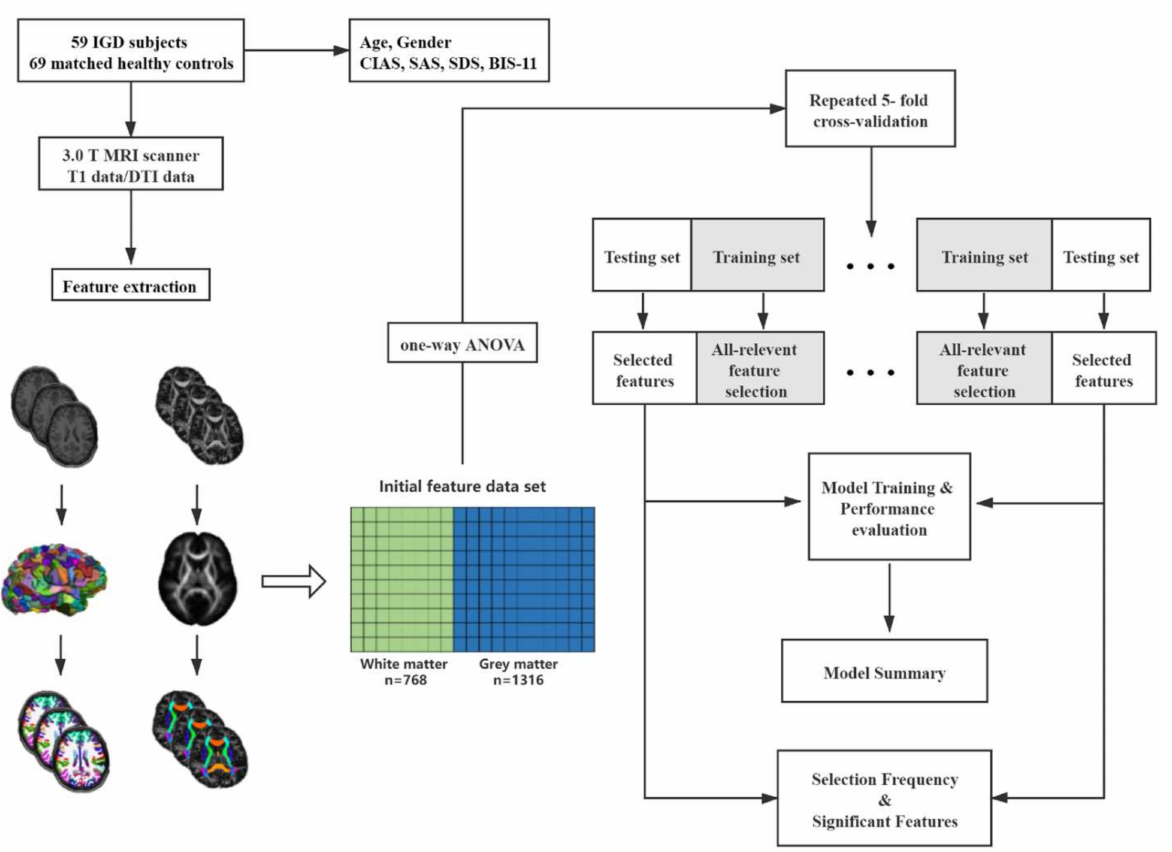
Figure 1. Flowchart of this study. IGD = Internet gaming disorder; CIAS = Chen Internet Addiction Scale; BIS-11 = Behavior impulsive scale-11; SAS = Self-rating anxiety scale; SDS = Self-rating depression